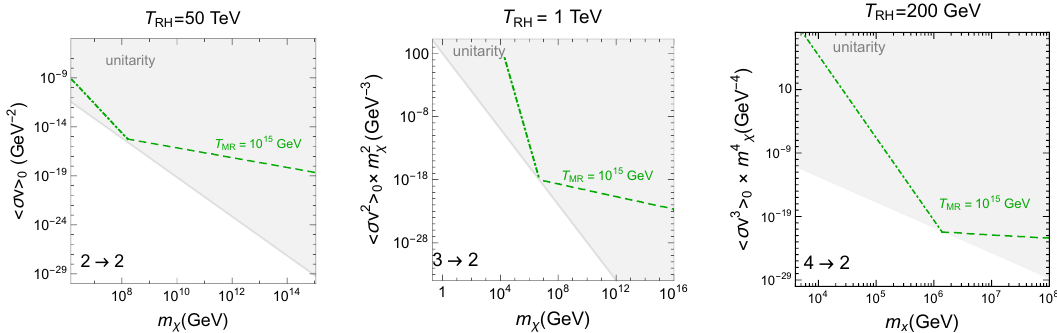
Figure 5 . Approximate maximum value of T RH for which no T MR values upto 10 15 GeV can accommodate the requirements of both DM relic density and unitarity, for the scenarios in which the dominant number-changing DM annihilations are of 2 → 2 (left panel), 3 → 2 (middle panel) and 4 → 2 (right panel) type. For details, see figure 2 and the related